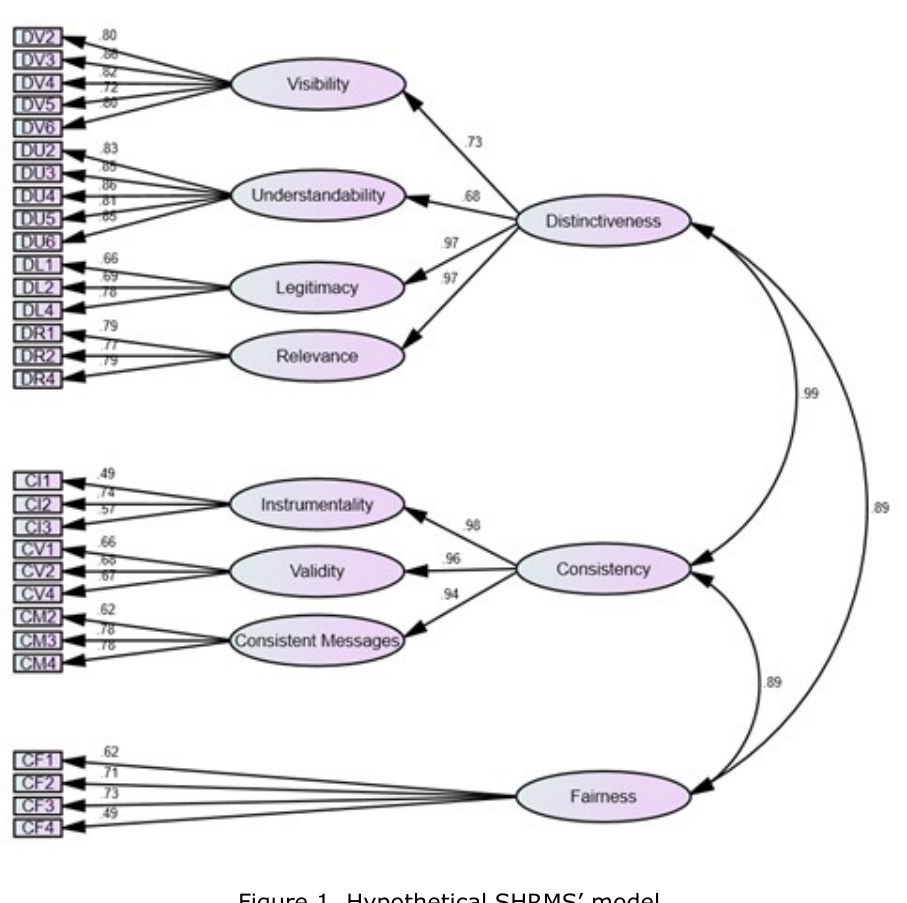
Figure 1. Hypothetical SHRMS’